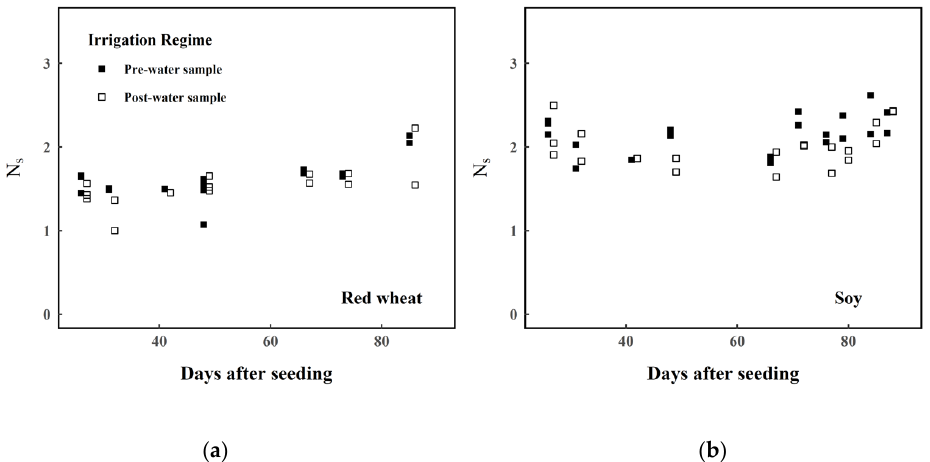
Figure 5. Estimated N s for the entire sample of the two species grown in the 2016 experiment: ( a ) red wheat; ( b ) soy. In each plot, the symbol indicates the two different irrigation regimes: Pre-water samples indicate estimated N s before the trays were watered and post-water samples indicate estimated N s 24-hours after the plants were watered.